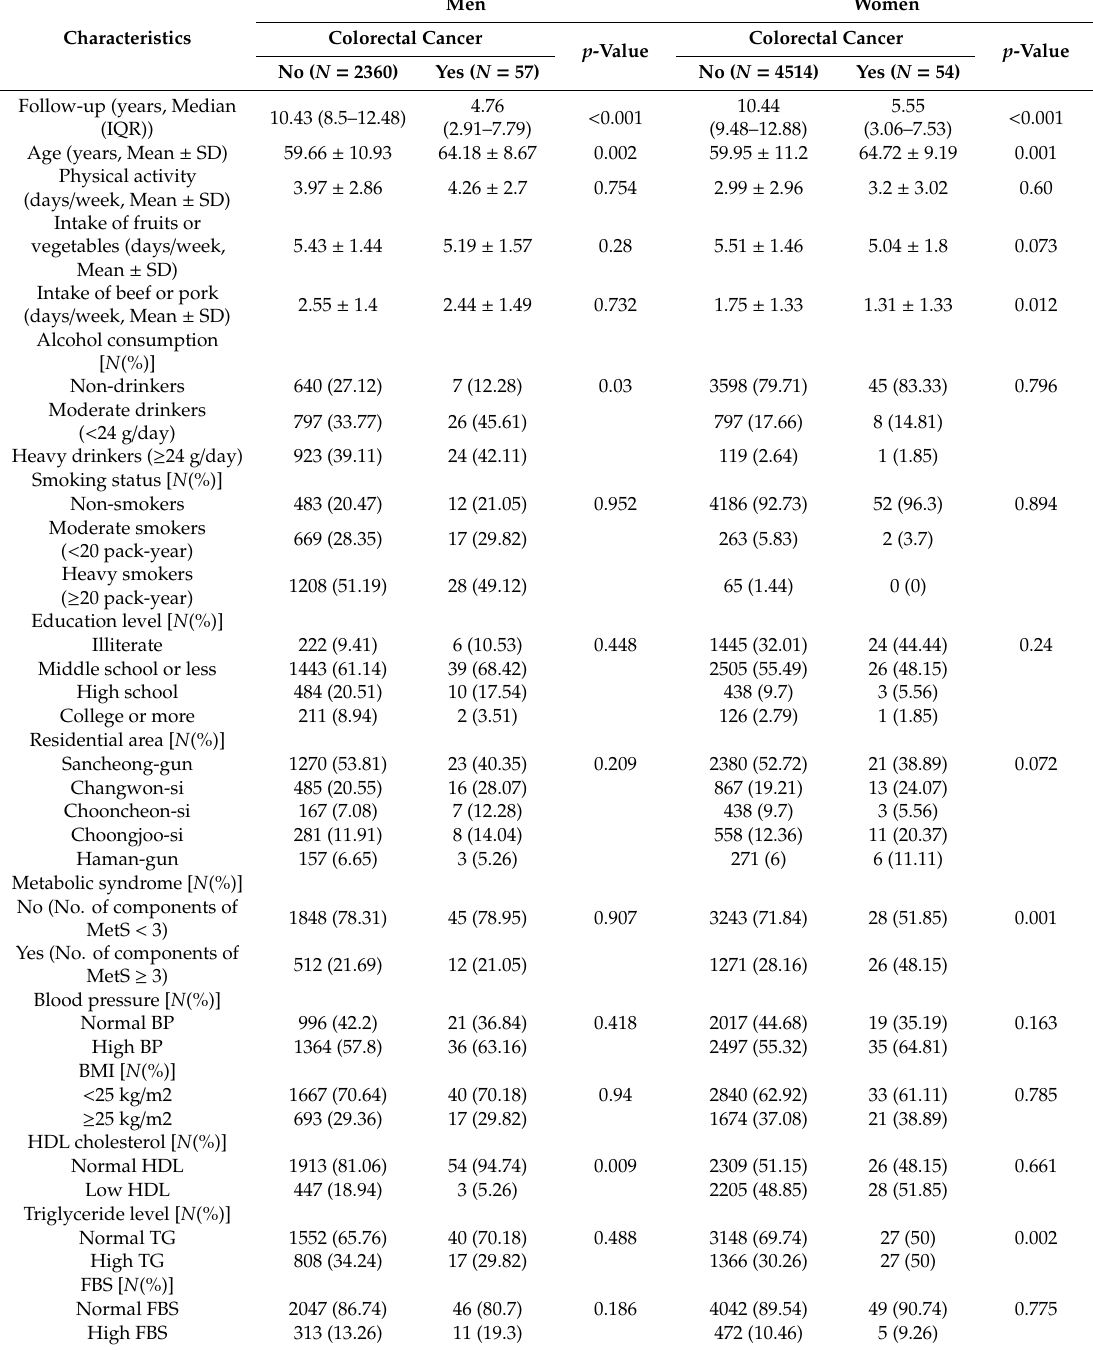
Table 1. Baseline characteristics of study